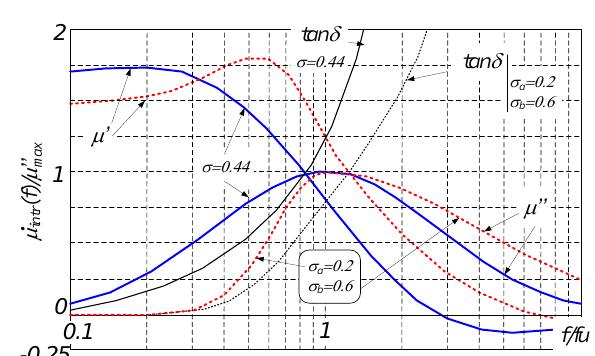
Fig. 7. Possibilities of the use of Eq. (18) for modelling symmetrical CIP (with 𝜎 = 0.44 ), and asymmetrical CIP (with 𝜎 𝑎 = 0.2 and 𝜎 𝑏 = 0.6 ) [20].